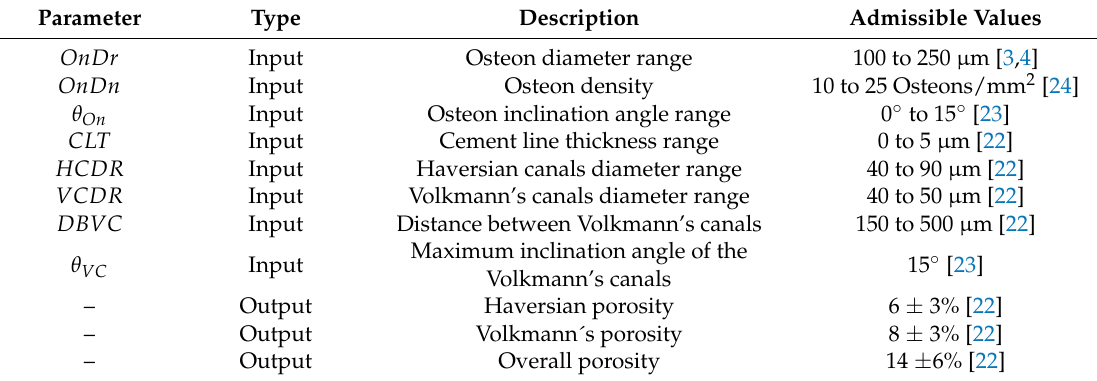
Table 2. Reported microstructural parameter values for healthy bone